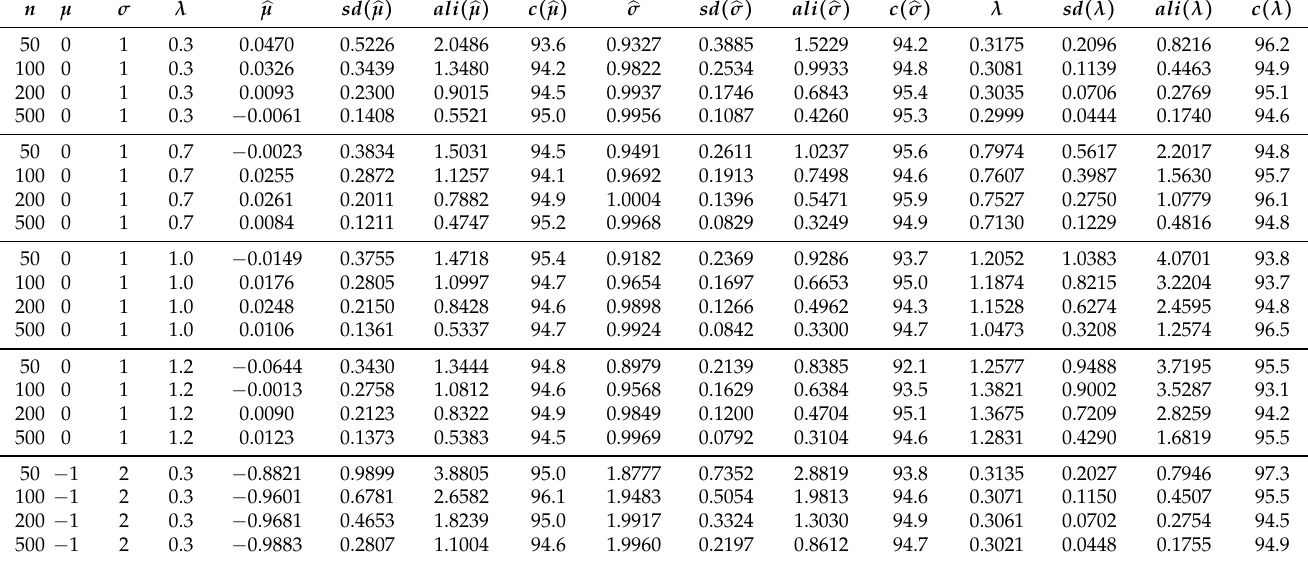
Table 3. MLE simulation of 1000 iterations of the model EML ( µ , σ , λ ) .